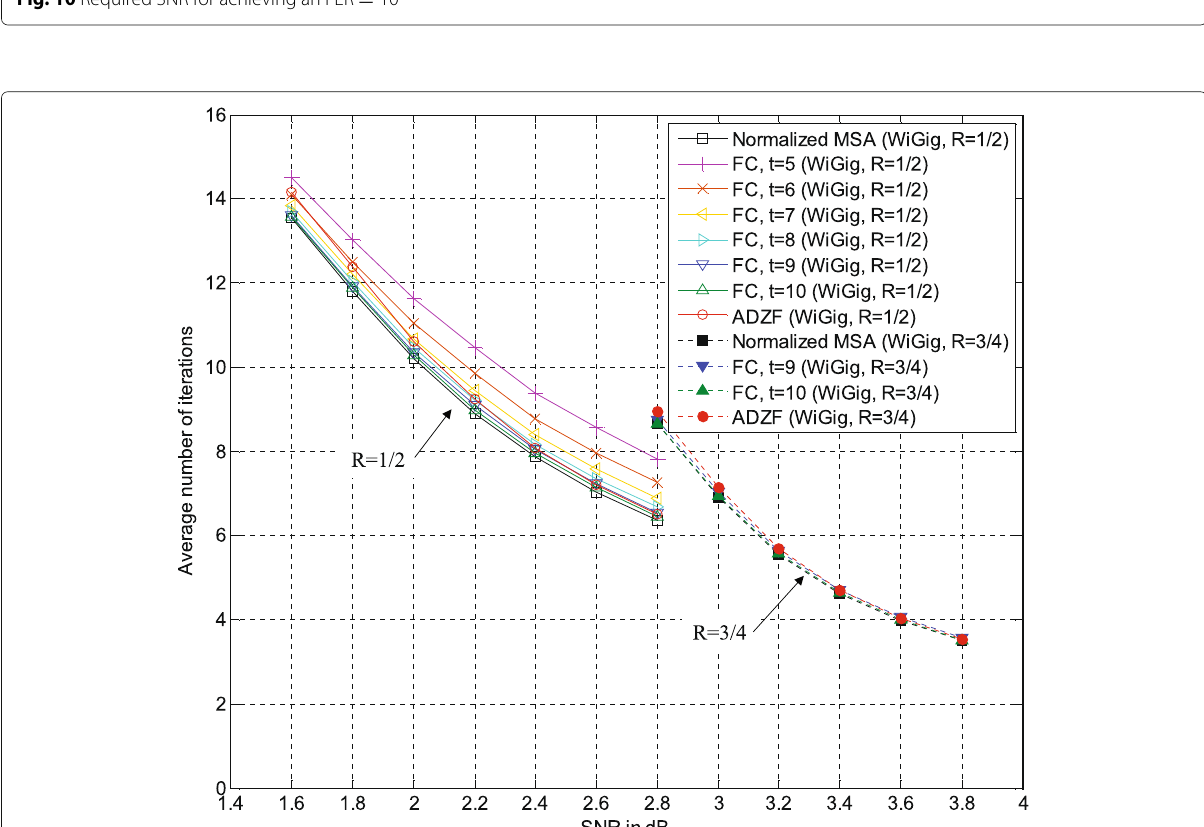
Fig. 10 Required SNR for achieving an FER = 10 − 3